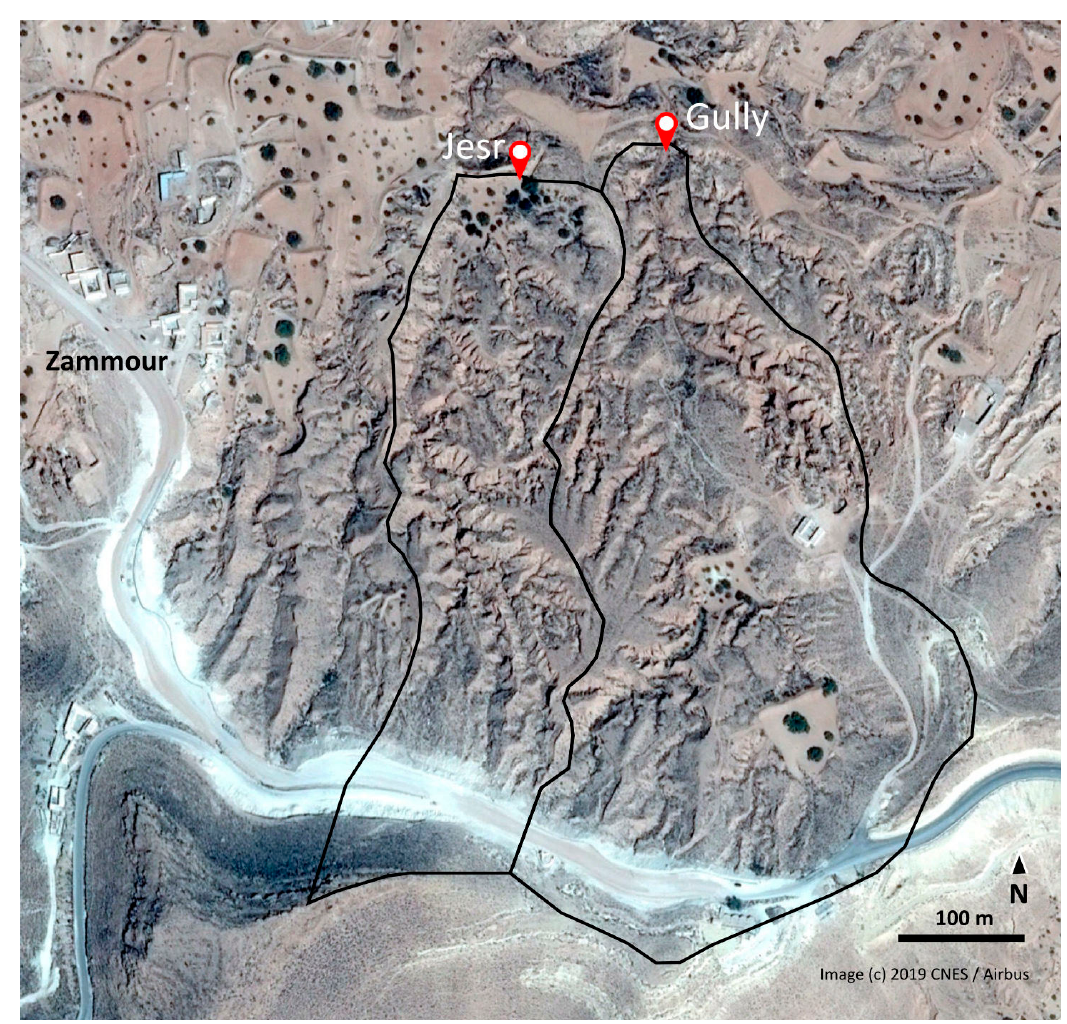
Figure 3. Location of the two measurement systems in the Jesr and in the gully, with their impluvium. The sites were chosen to represent similar local geology, soil texture, climate and impluvium topography. They are situated in the Chaabet el Fougania sub-catchment, a tributary of the Wadi Zammour. The gully impluvium has an area of 129,400 m 2 , whereas the Jesr impluvium is smaller, with an area of 76,000 m 2 .